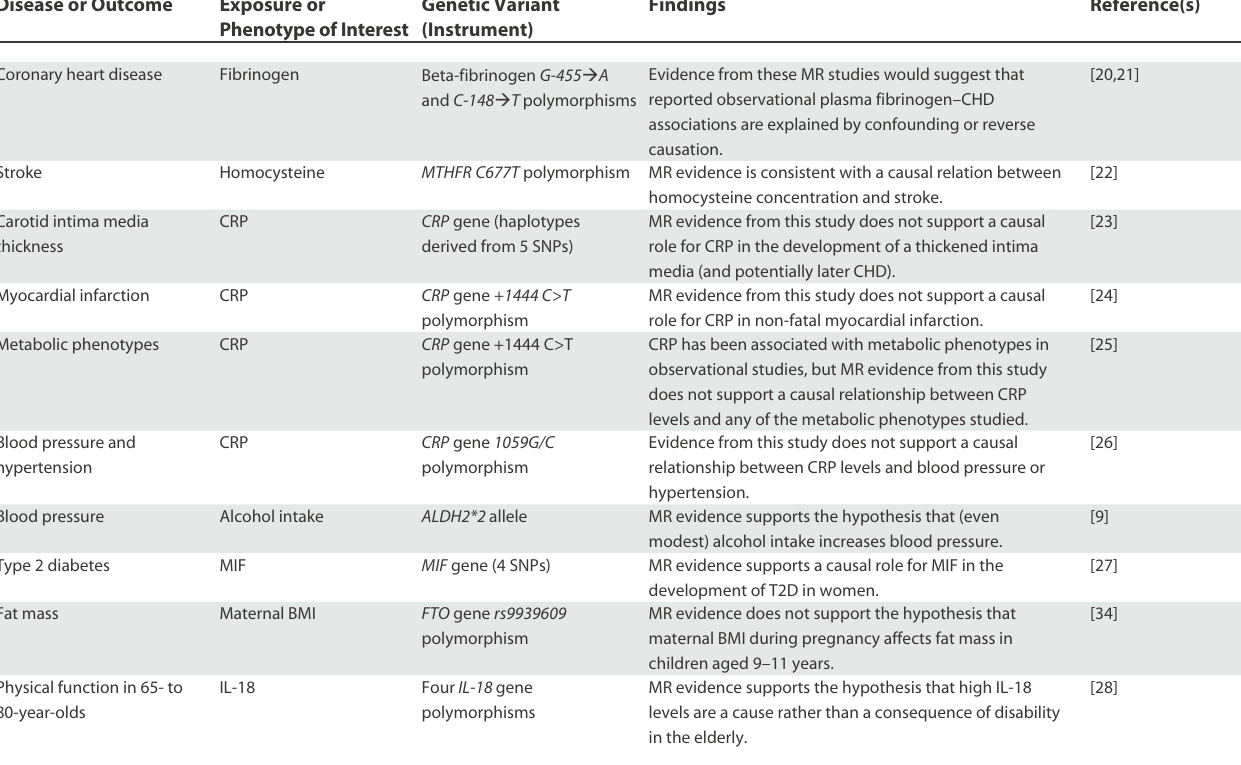
Table 1. Examples of Mendelian Randomisation Studies Disease or